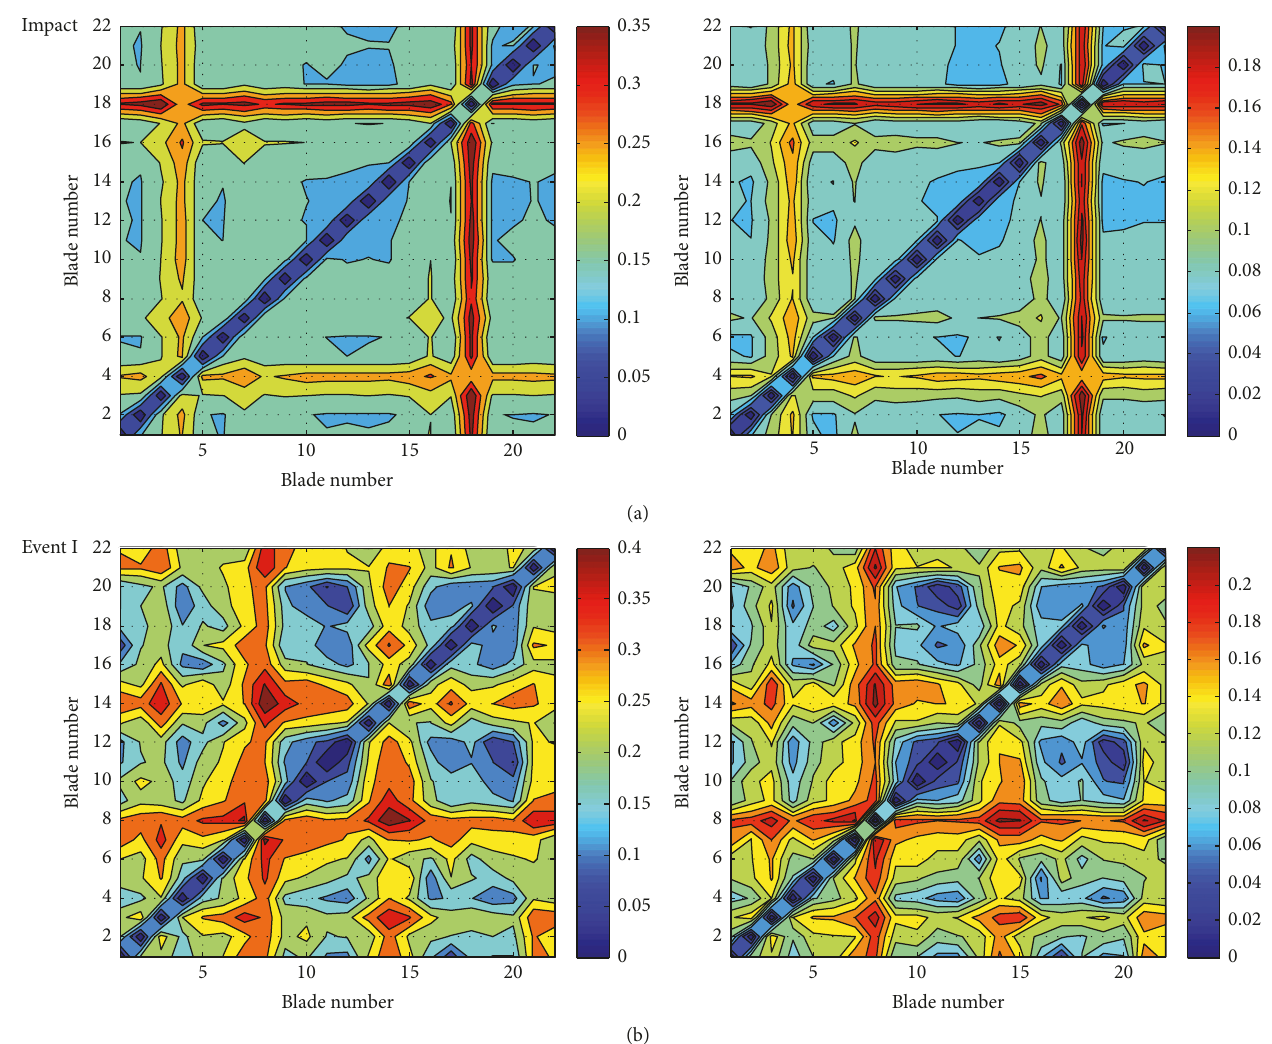
Figure 12: (a) Mean value of the reference vector; (b) standard